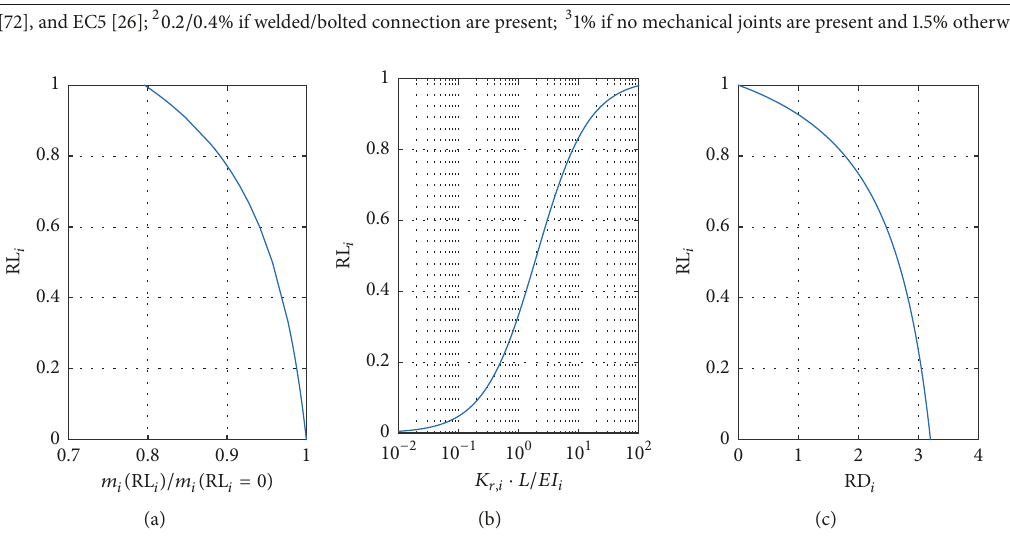
Figure 3: Restrained level RL 𝑖 as a function of 𝑚 𝑖 ( RL 𝑖 )/𝑚 𝑖 ( RL 𝑖 = 0) (a), 𝐾 𝑟,𝑖 𝐿/𝐸𝐼 𝑖 (b), and RD 𝑖